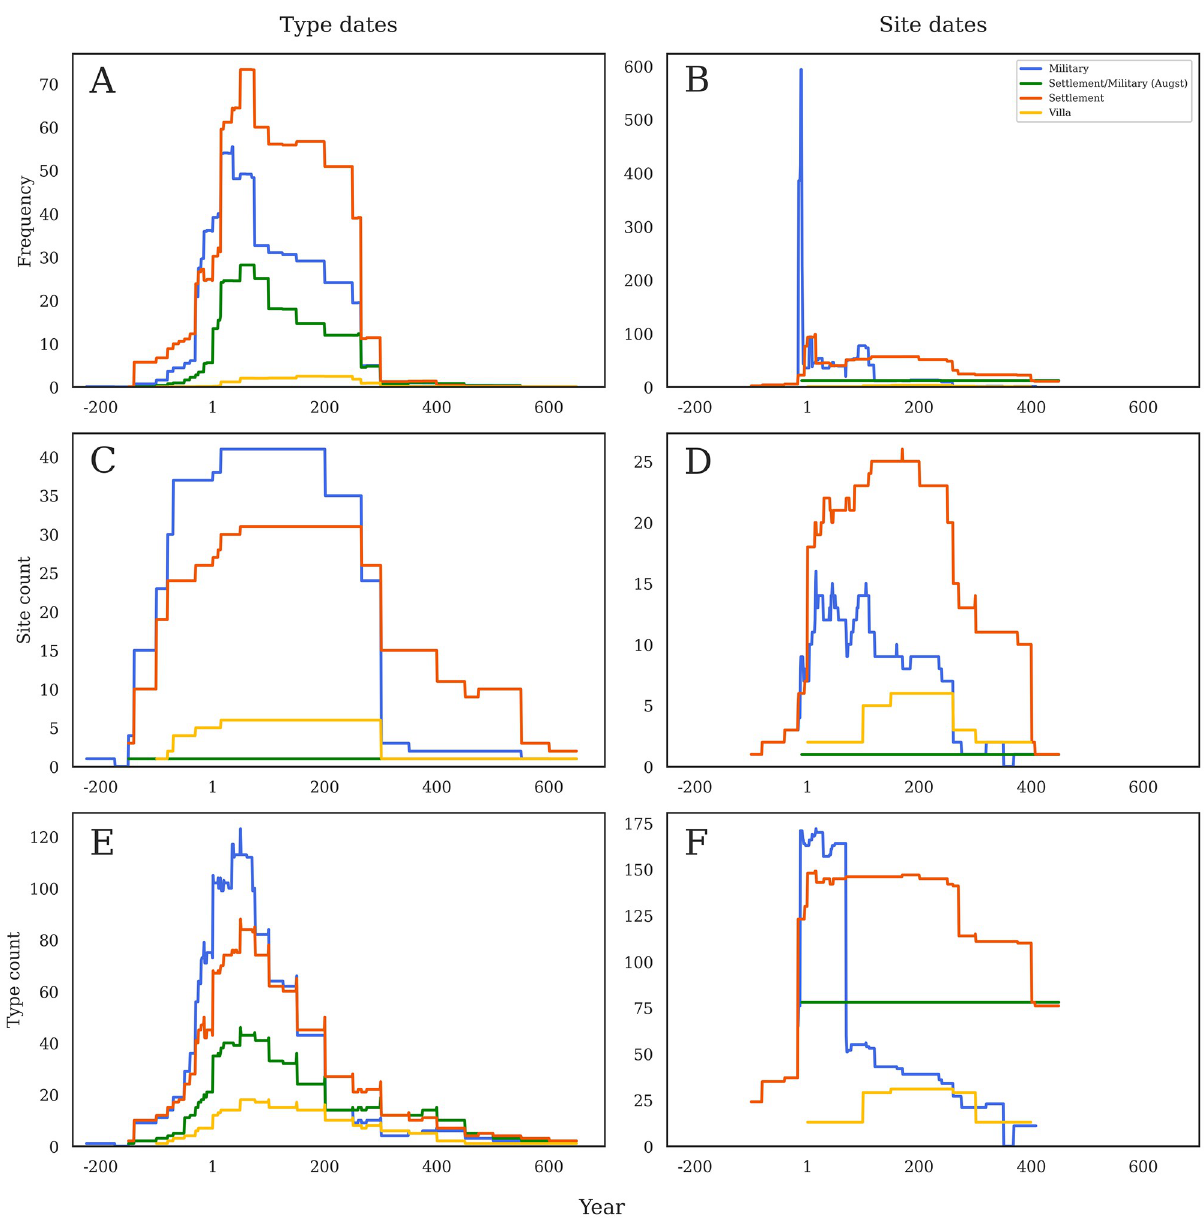
Fig 10. a-f. Settlement types. Comparison of four main settlement types across the three different methods of analysis according to production dates (left) and consumption dates (right). Note that Y axes are not constant. https://doi.org/10.1371/journal.pone.0279382.g010 Fig 10e shows the RAAD type number count per site type per year according to amphora